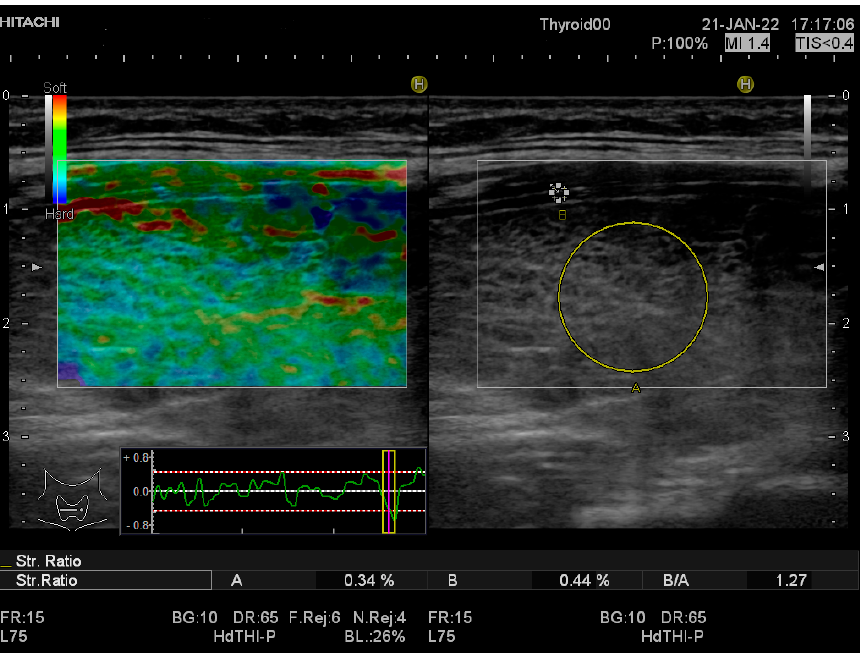
Figure 1. Strain elastography ( left ) and conventional US ( right ) of a girl, age 17, diagnosed with CAT; The yellow circle A is the local ROI on the thyroid tissue; the yellow circle B is the local ROI on the adjacent sternocleidomastoid muscle. SR = 1.27.